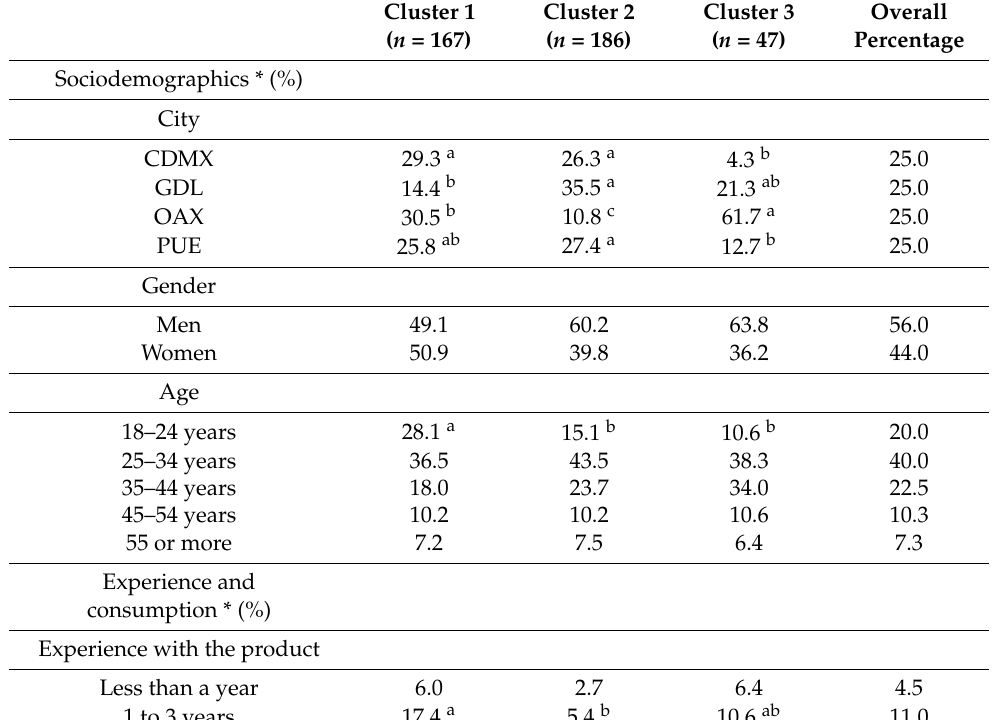
Table 5. Percentage of individuals in each sociodemographic level and consumption habits *, and mean values of the different constructs ** and the traditionality dimensions *** within each segment of tequila